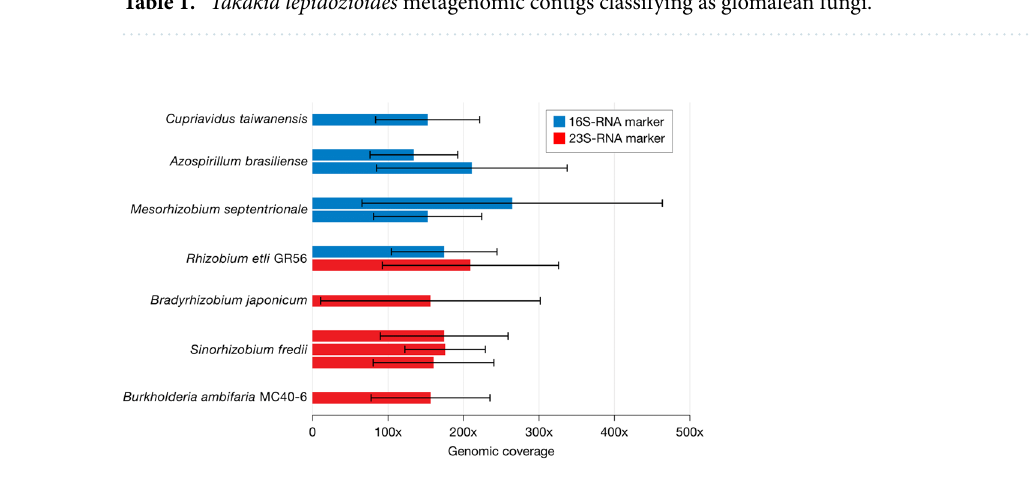
Table 1. Takakia lepidozioides metagenomic contigs classifying as glomalean